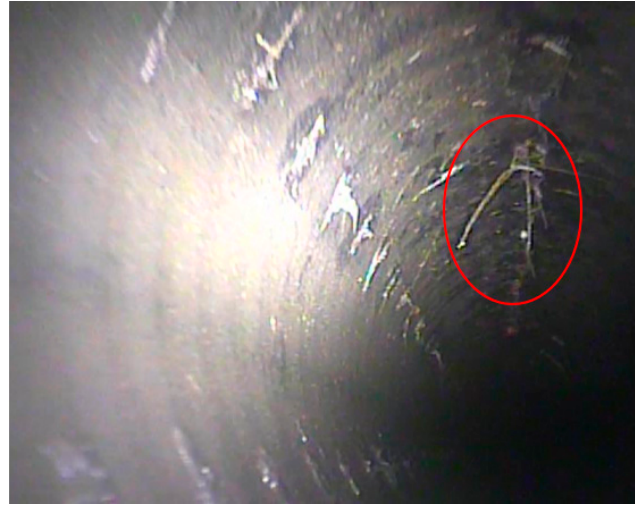
Figure 8. Root penetration into the distribution pipe during subsurface cleaning in June 2016.